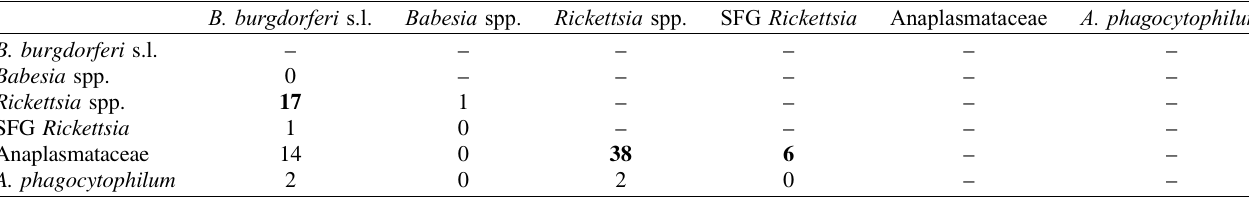
Table 3. The observed frequency of co-infections detected by PCR assays in I. ricinus